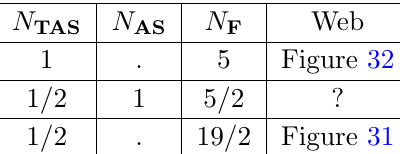
Table 2 . Sp(3) marginal theories with rank-3 antisymmetric half-hypermultiplets and matter in other representations.